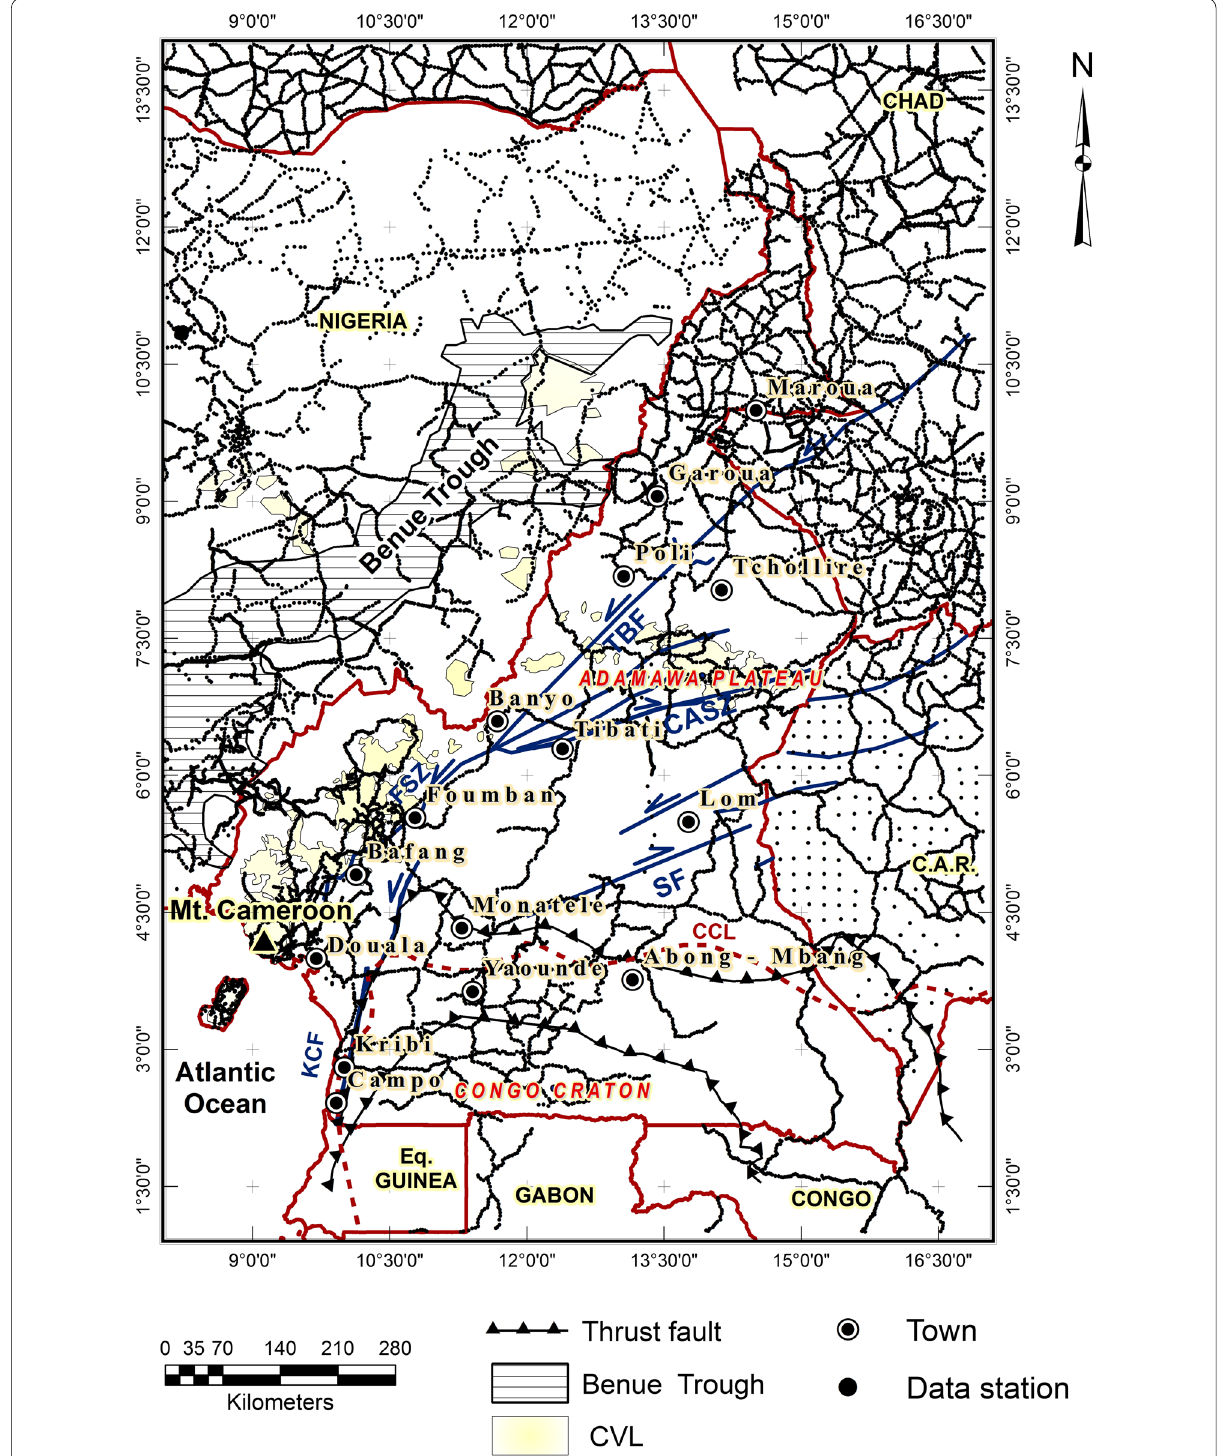
Fig. 2 Gravity data station map of the area (Collignon